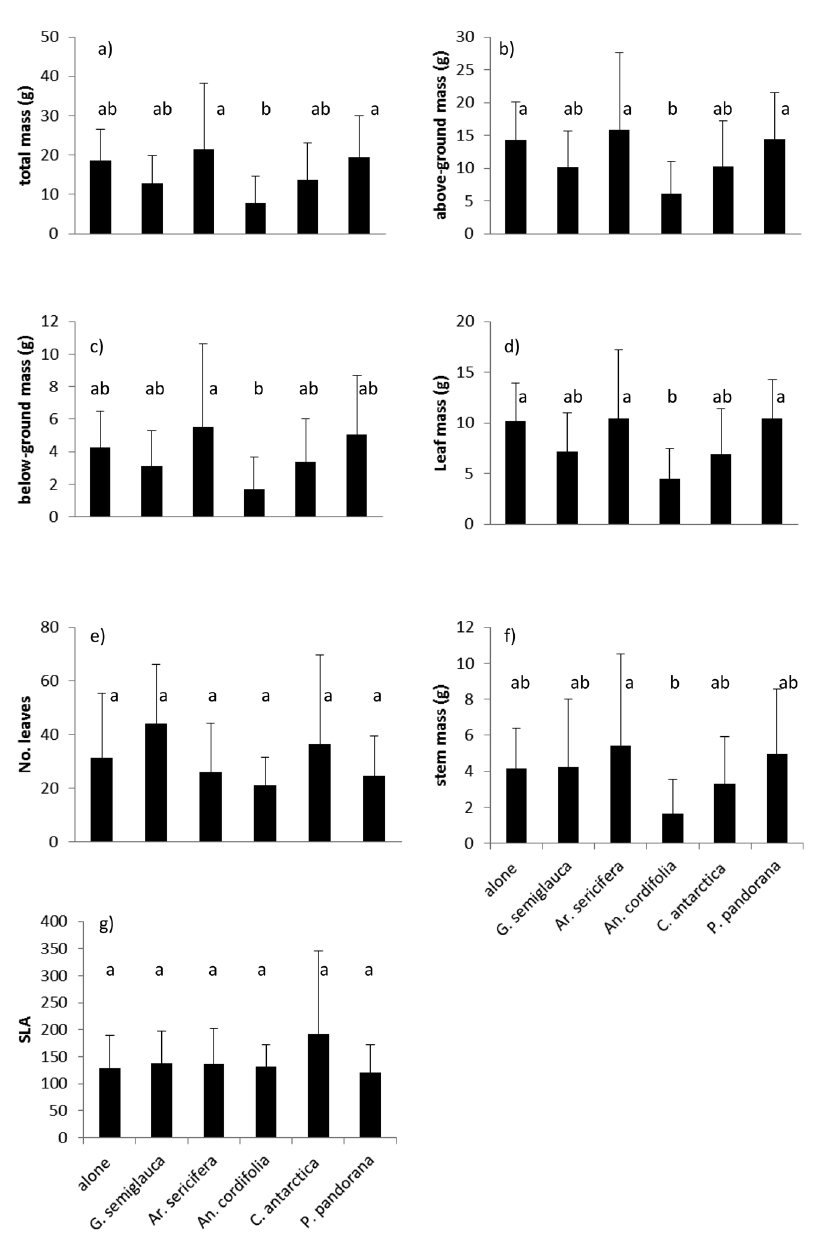
Figure 2. Average a total biomass b above-ground biomass c below-ground biomass d leaf biomass e number of leaves f stem biomass and g specific leaf area (SLA) of Guioa semiglauca seedlings grown under different competition treatments: alone, with another G.semiglauca (with conspecific), with two invasive lianas, Araujia sericifera, Anredera cordifolia, and two native lianas, Cissus antarctica and Pandorea pandorana . Light levels are pooled for each mean. Different letters represent significant differences be- tween bars based on Tukeys